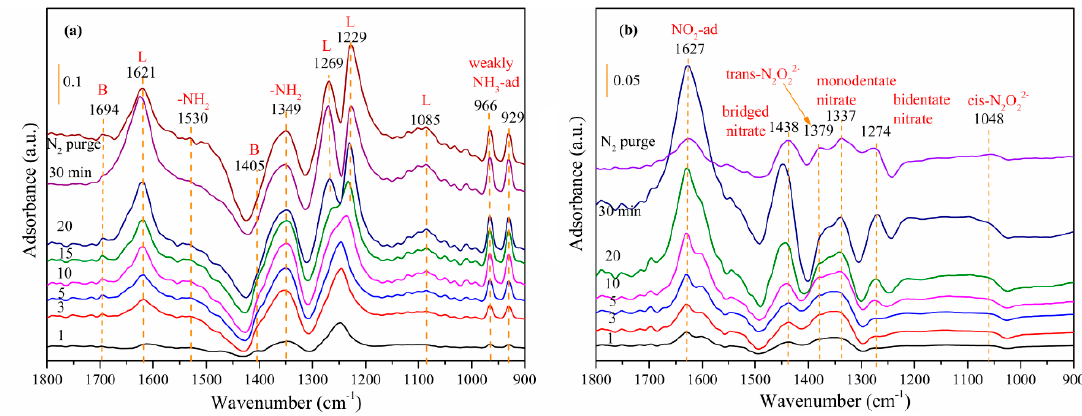
Figure 4. In-situ DRIFT spectra of NH 3 adsorption over the Mn 0.15 Fe 0.05 /FA exposed to ( a ) 1000 ppm NH 3 /N 2 and ( b ) 1000 ppm NO + 5% O 2 at 150 °C.